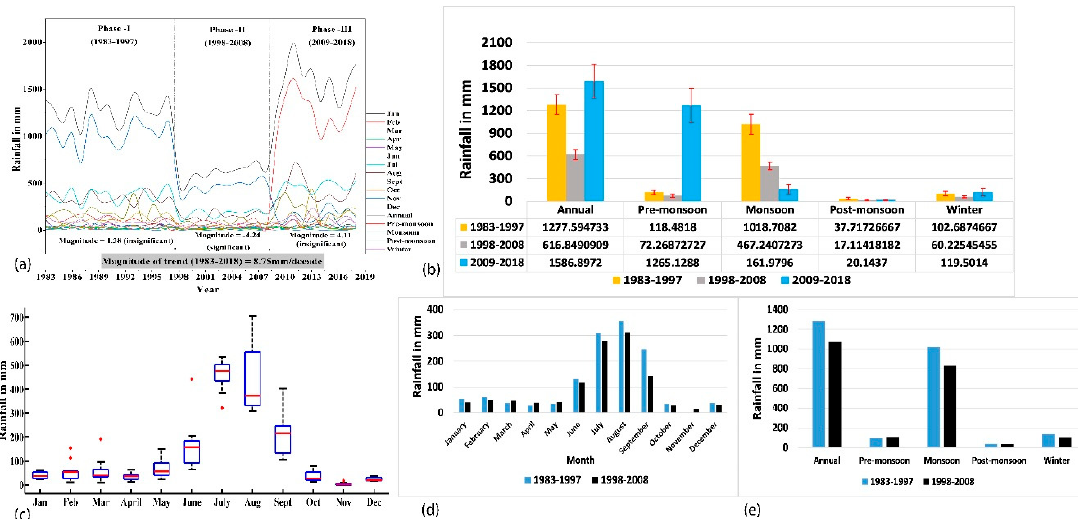
Figure 7. Long-term temporal distribution of monthly rainfall and annual magnitude of trends in mm/decade ( a ) monthly values from 1983 to 2018, ( b ) mean annual and seasonal rainfall for three distinct rainfall phases with error bars from 1983 to 2018 ( c ) box and whisker plots show monthly rainfall values from 2009 to 2018 ( d , e ) mean annual, seasonal and monthly rainfall of station observed